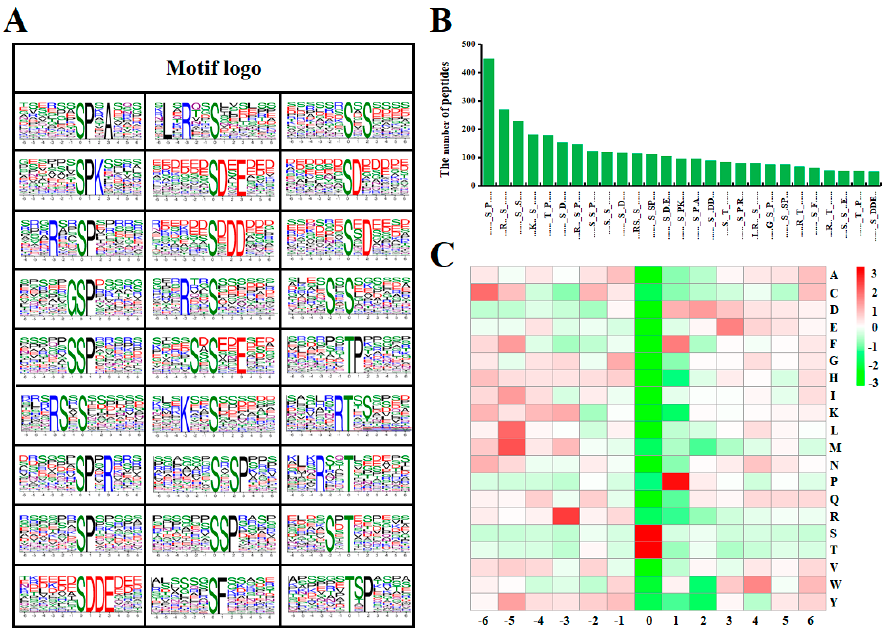
Figure 3. Analysis of phosphorylation sites. ( A ) Sequence motif analysis of phosphorylation sites. ( B ) The number of identified peptides containing phosphorylation sites in each motif. ( C ) The relative abundance of amino acid residues flanking the phosphorylation sites represented by an intensity map. The intensity map shows the relative abundance for six amino acids from the phosphorylation site. The colors in the intensity map represent the log10 of the ratio of frequencies (red shows enrichment, green shows depletion).